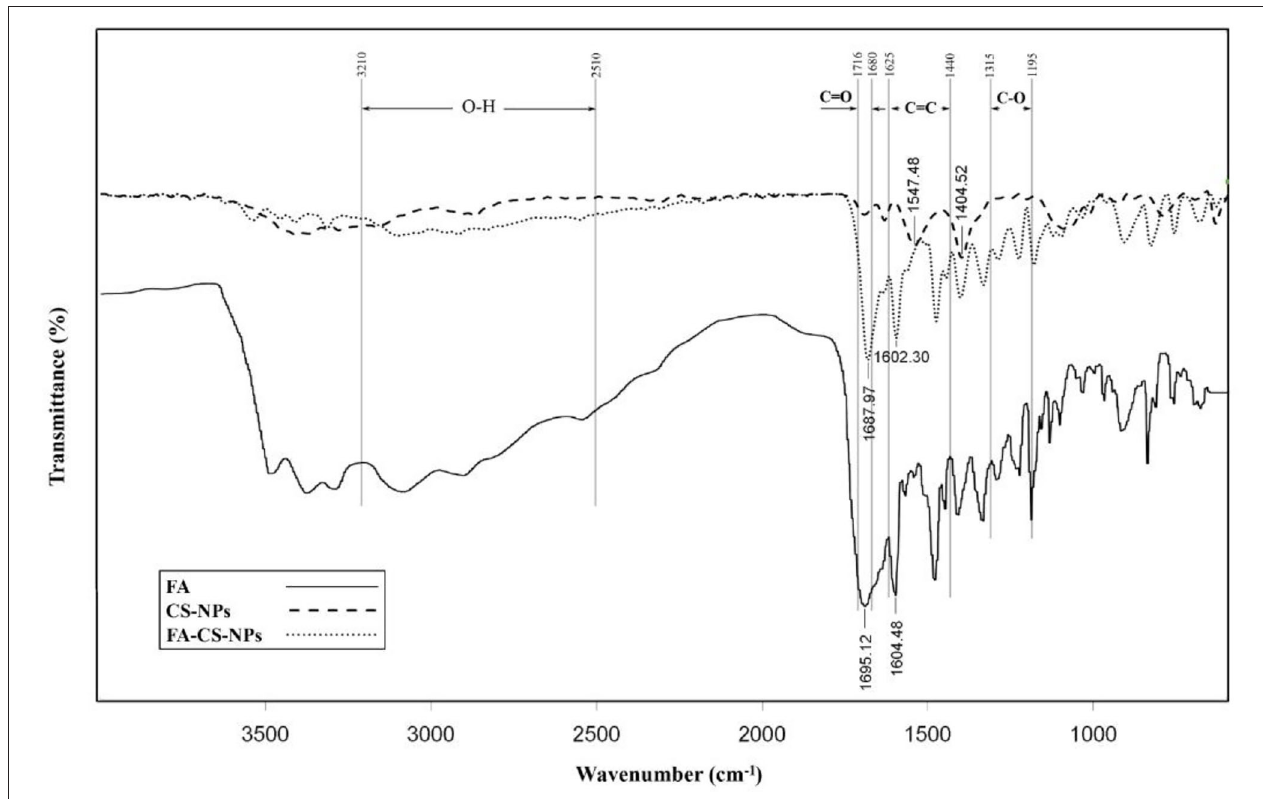
FIGURE 3 | Fourier transform infrared spectra of folic acid (FA), chitosan nanoparticles (CS-NPs), and folic acid coated chitosan nanoparticles (FA-CS-NPs).